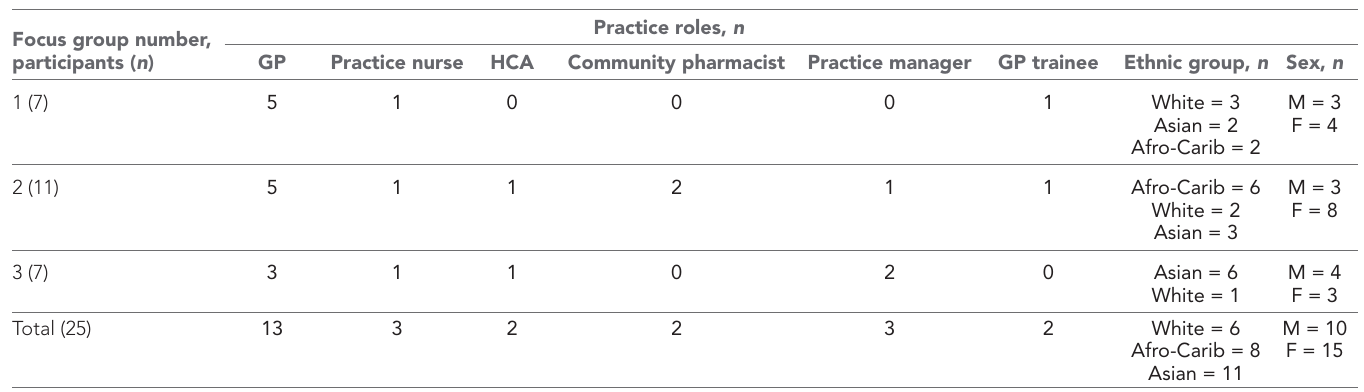
Table 1 Demographic and professional characteristics of study participants Focus group number, participants ( n